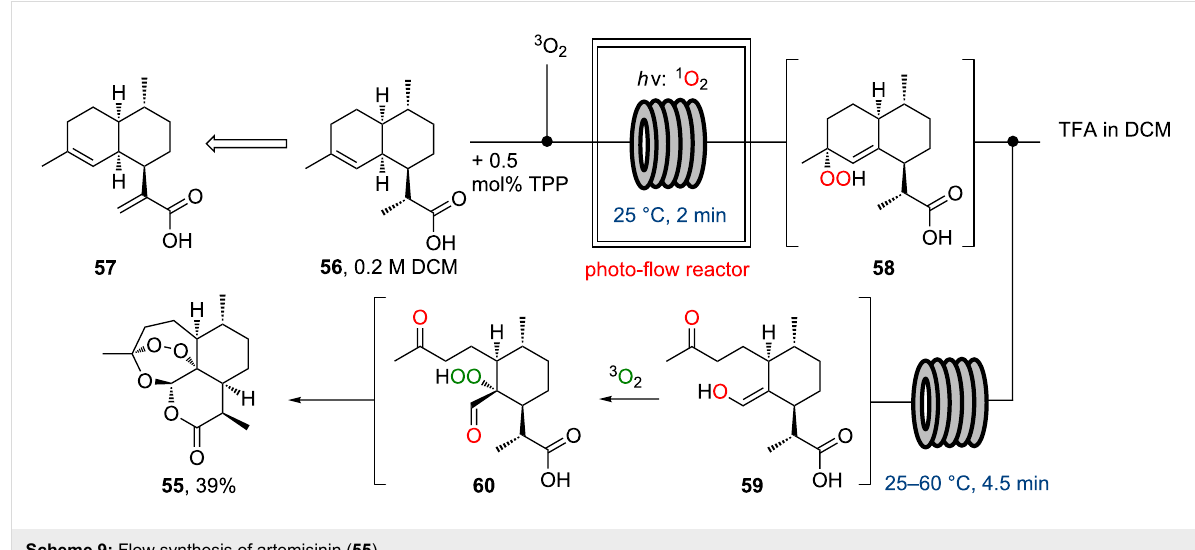
Scheme 9: Flow synthesis of artemisinin ( 55